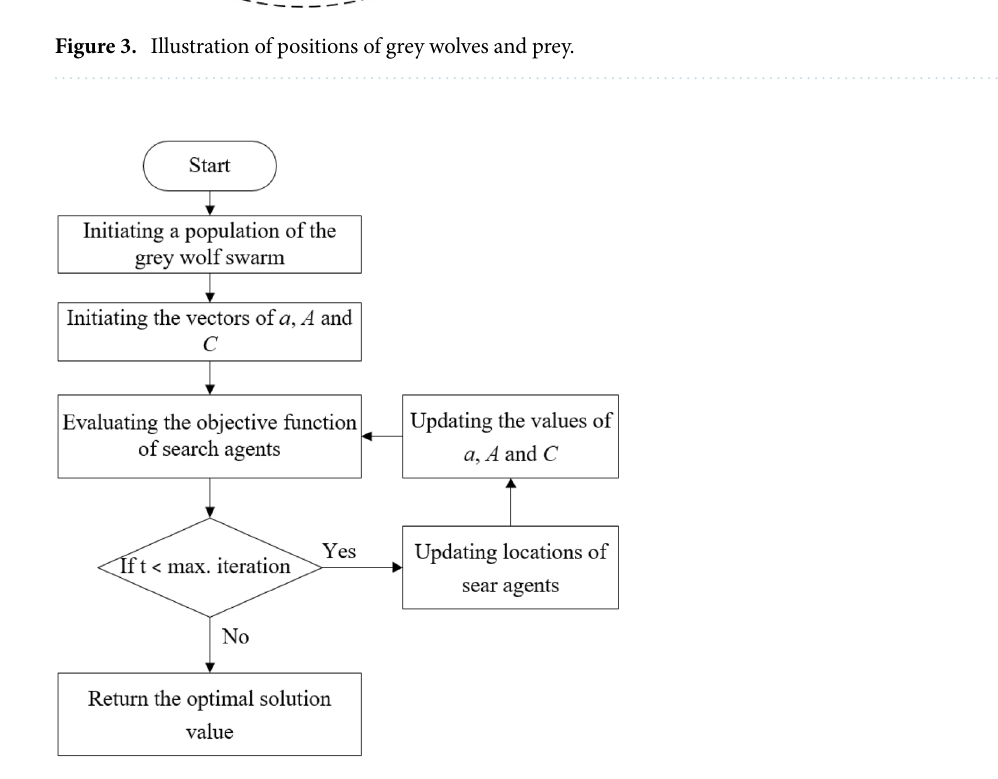
Figure 4. The flowchart of the grey wolf optimization